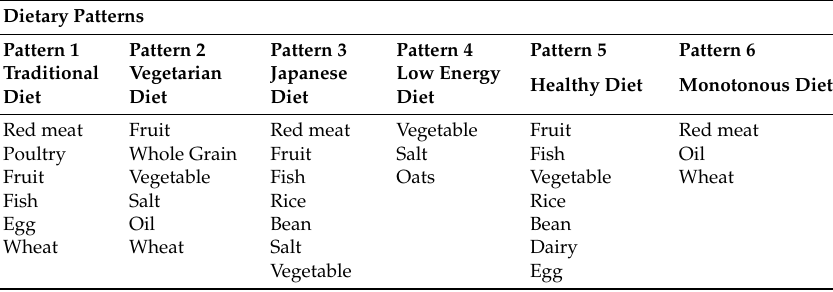
Table 4. Distribution of factorial loads of dietary patterns.